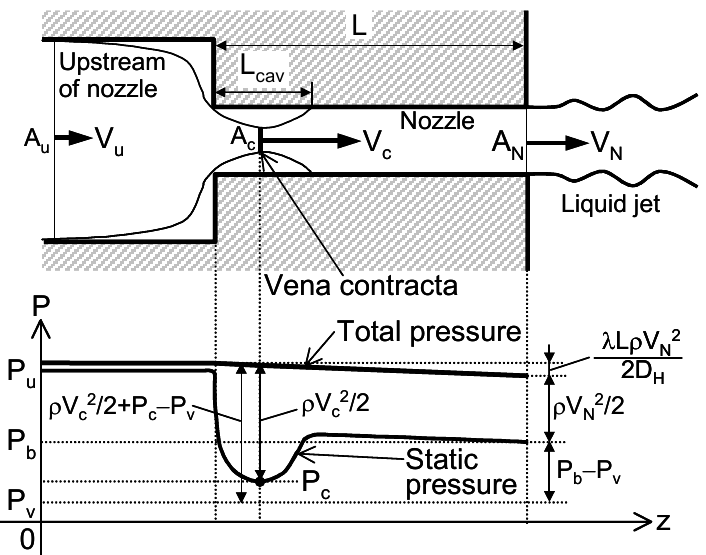
Fig. 7 Pressure distribution in a cavitating